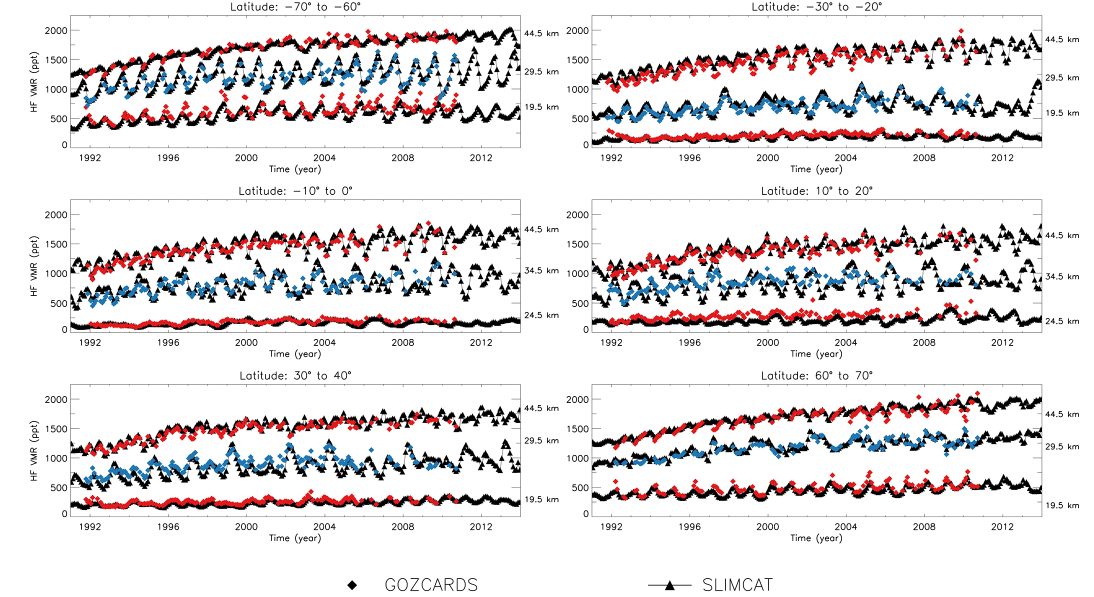
Figure 8. The GOZCARDS and SLIMCAT HF time series for selected altitude–latitude bin combinations. Observations are plotted between October 1991 and September